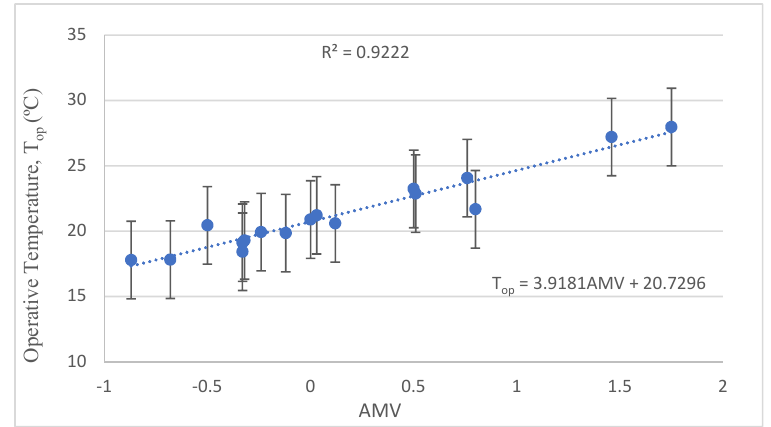
Figure 4. Linear relation between T op and AMV.